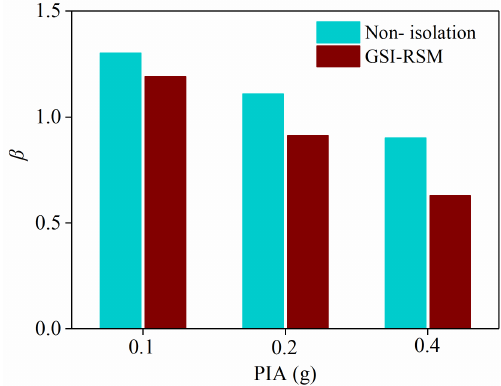
Figure 17. Acceleration response transfer coefficient.